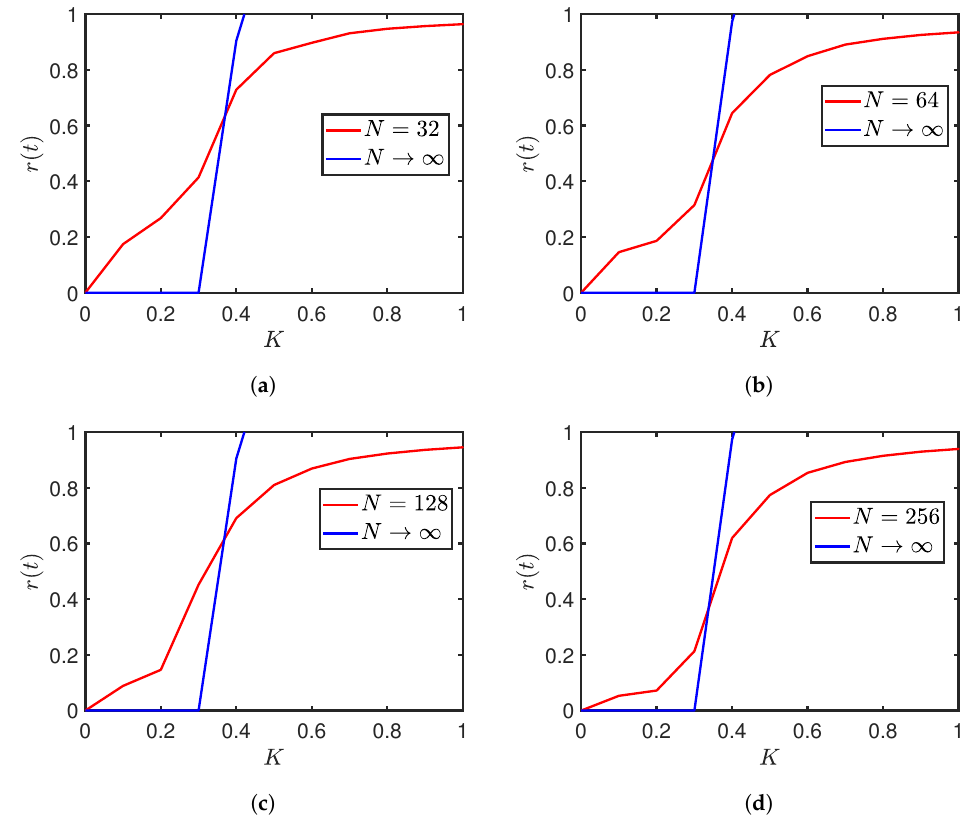
Figure 1. r ( t ) vs. K plots of ( a ) 32, ( b ) 64, ( c ) 128, and ( d ) 256 oscillators: simulation versus approximated solution (Equation (9)) near critical coupling strength K c . w j are drawn from the Gaussian with mean µ = 0 & standard deviation σ = 0.2. K c approaches its analytical counterpart (evaluated for N → ∞ ) as the number of oscillators increases from 32 to